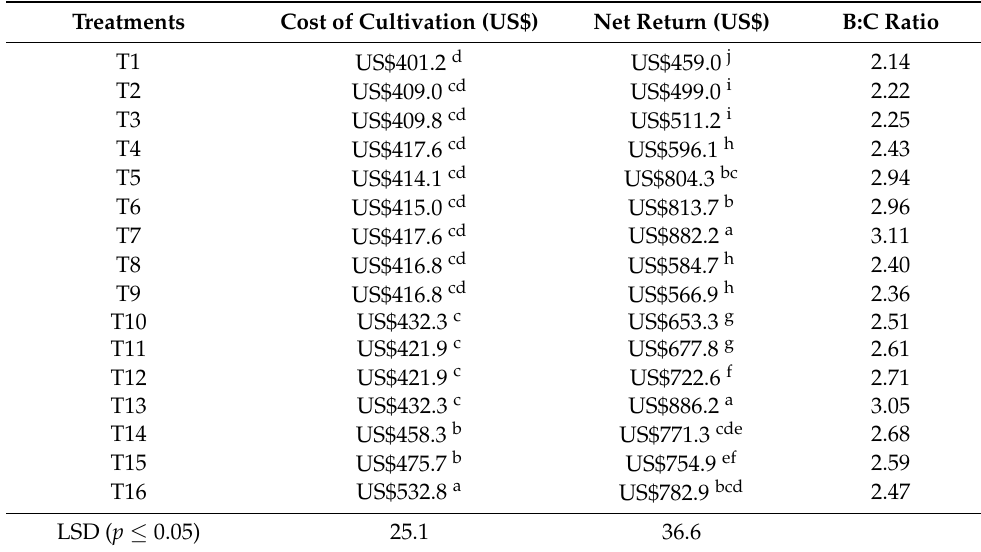
Table 5. Effect of mineral, chelated and nanoforms of Zn and Fe on the economics of chickpeas.